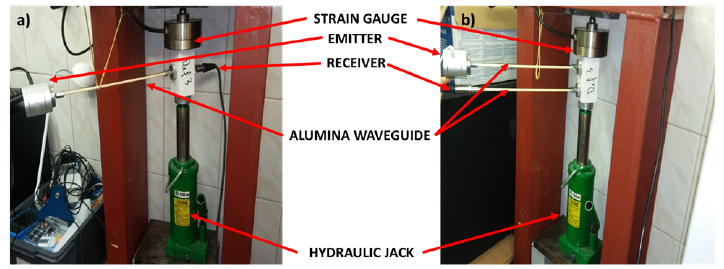
Figure 6. The SAS arrangement working with ( a ) one waveguide and ( b ) two